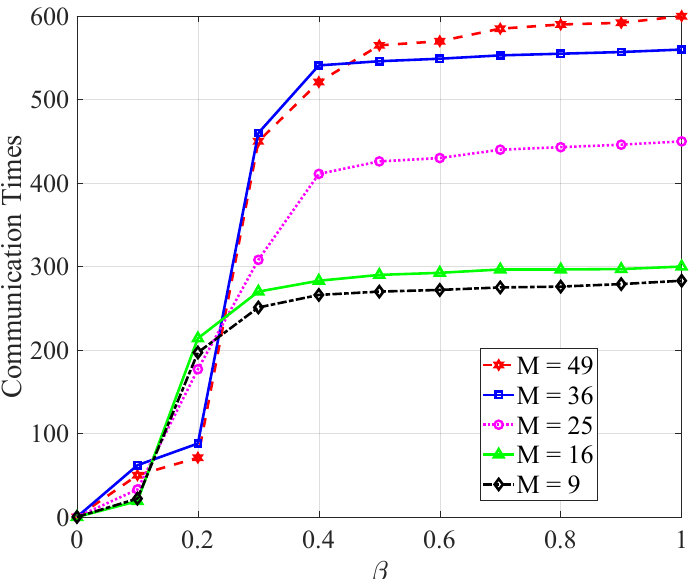
Figure 1. Comparison of the communication times of different schemes versus β